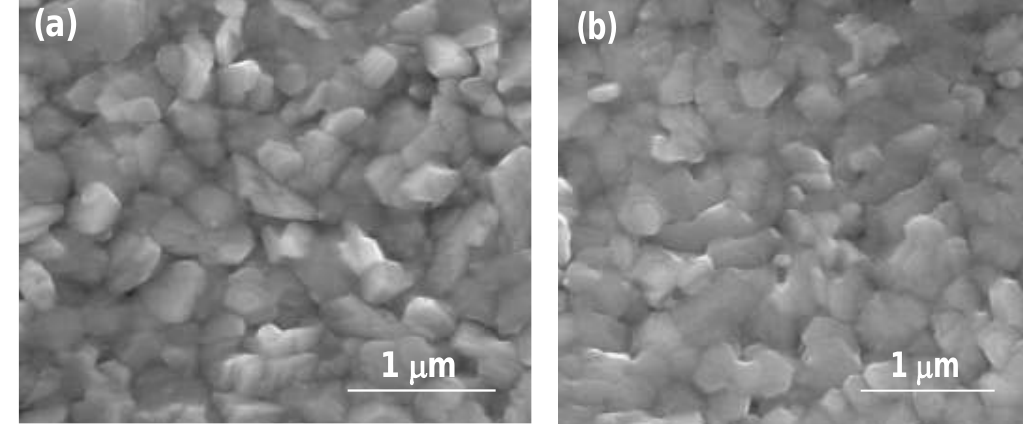
Figure 1: PVS films deposited on mp-TiO modified mp-TiO